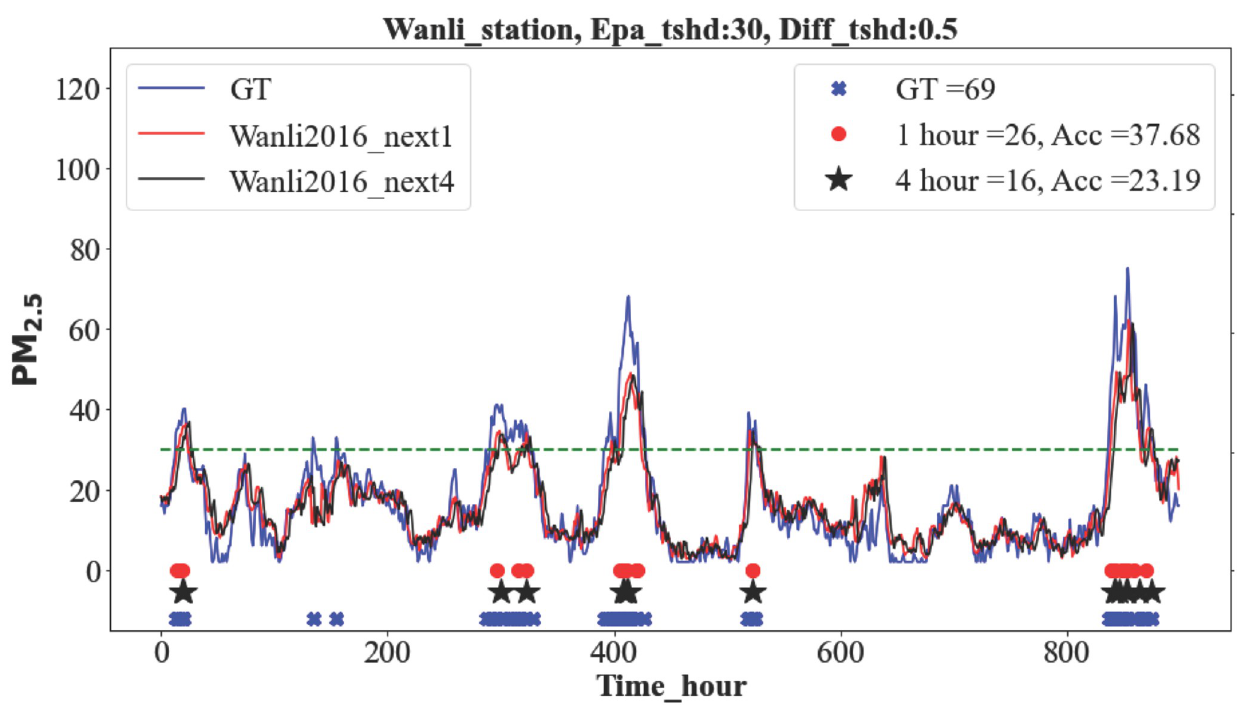
Fig 5. Classify remote pollutant. Prediction of +1h and +4h with ground truth at Wanli station. The dots and stars at the bottom show all peaks that meet both EPA and Differential conditions.